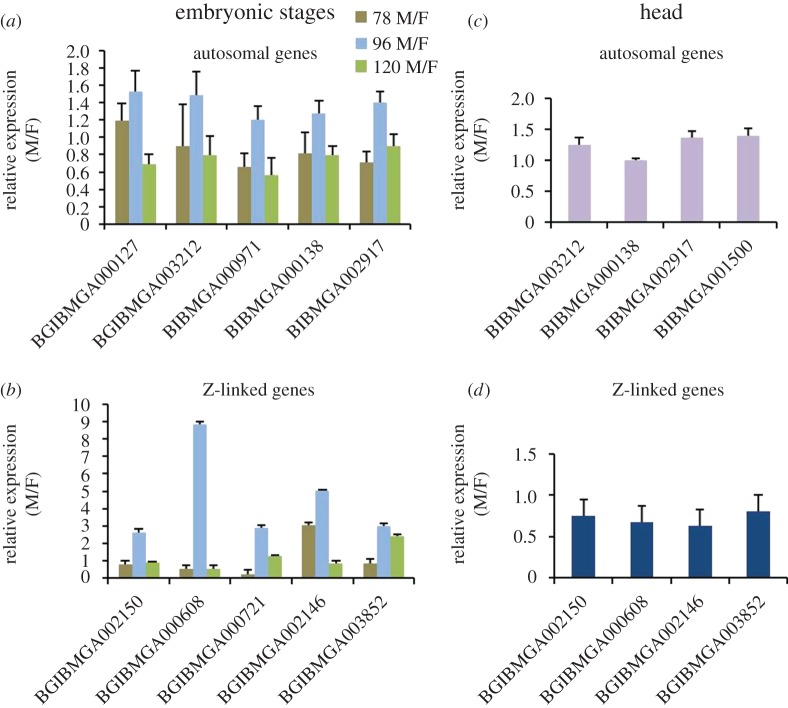
Validation of RNA-seq results of embryonic stages (78, 96 and 120 h) and head samples by qRT-PCR. rp49 was used as an endogenous reference expression. Female samples were used as calibrators; hence, the relative expression (M/F) of females can be taken as 1 for all the genes. The relative expression of selected five autosomal (a) and five Z-linked genes (b) for the three embryonic stages and four equally expressing (M/F = approximately 1) autosomal (c) and four Z-linked genes (d) were shown in the head samples.